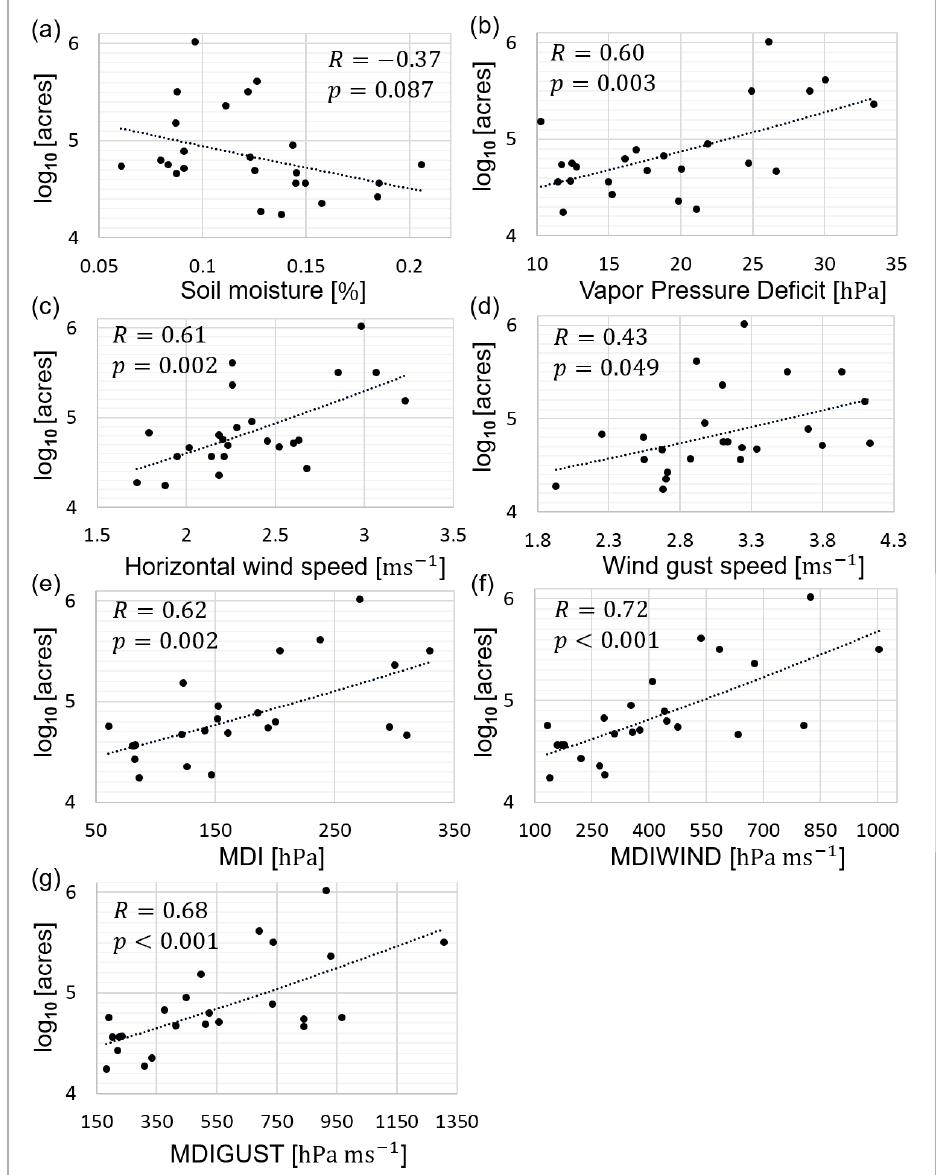
Figure 4. Correlation between the logarithms of burned area size and the hydrological/meteorological variables/indices for the target wildfires. ( a ) Soil moisture, ( b ) vapor pressure deficit, ( c ) horizontal wind speed, ( d ) wind gust speed, ( e ) Moisture Deficit Index (MDI), ( f ) MDIWIND, and ( g ) MDIGUST.